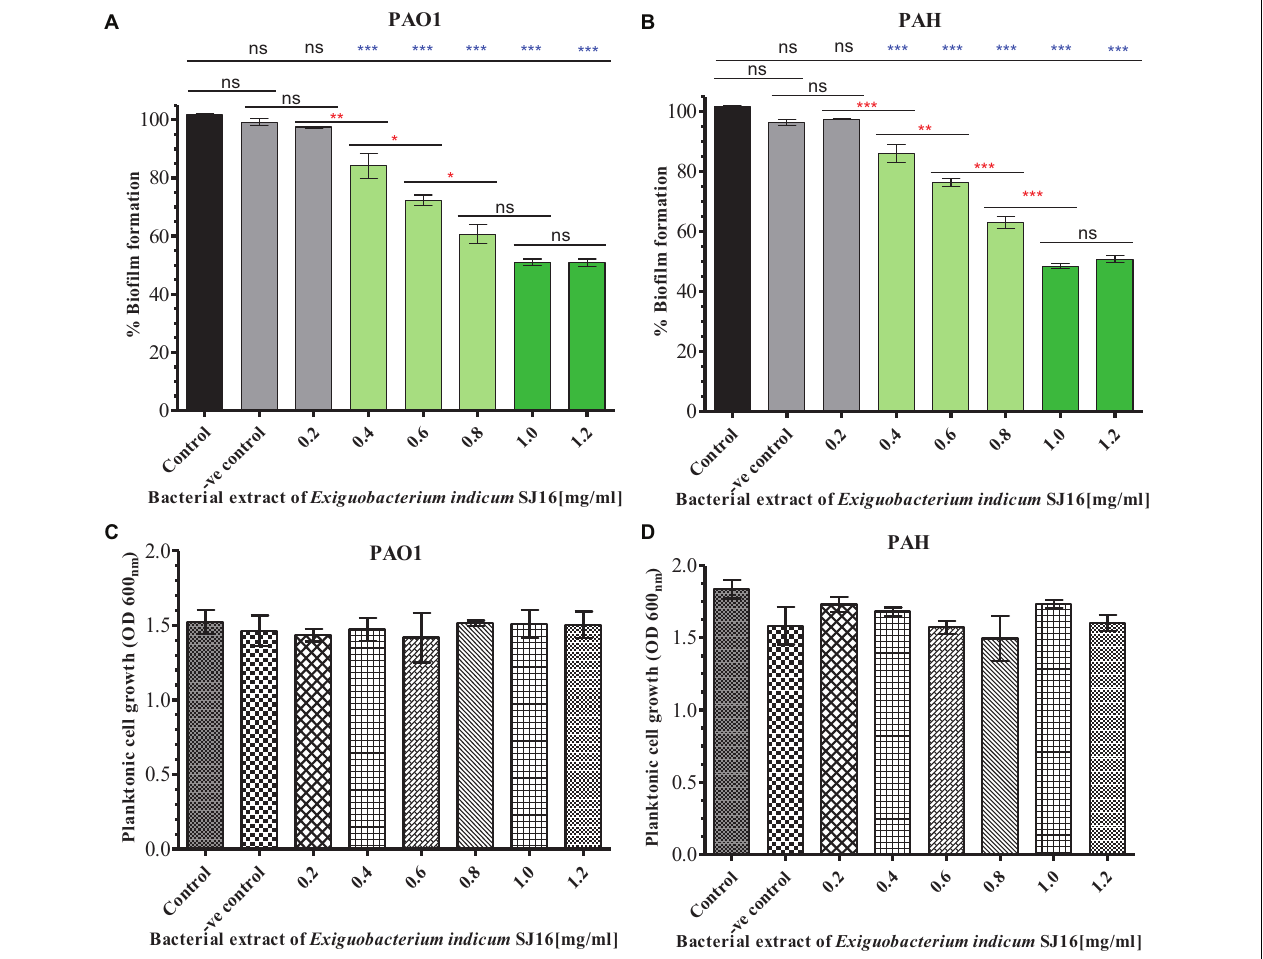
FIGURE 3 | Effect of E. indicum SJ16 extract on biofilm formation and planktonic growth of P. aeruginosa . Different concentration of bacterial extracts (0.2–1.2 mg/ml) ware tested against the biofilm forming reference P. aeruginosa strains PAO1 (A) and PAH (B) . The same concentrations of bacterial extracts were also tested for the inhibitory effect on the planktonic growth of PAO1 (C) and PAH (D) strains. Tests without extract and with methanol were considered as control and negative control, respectively. “ ∗ ”, “ ∗∗ ” and “ ∗∗∗ ” Indicates significant differences from the control at P < 0.05, P < 0.01, and P < 0.001,